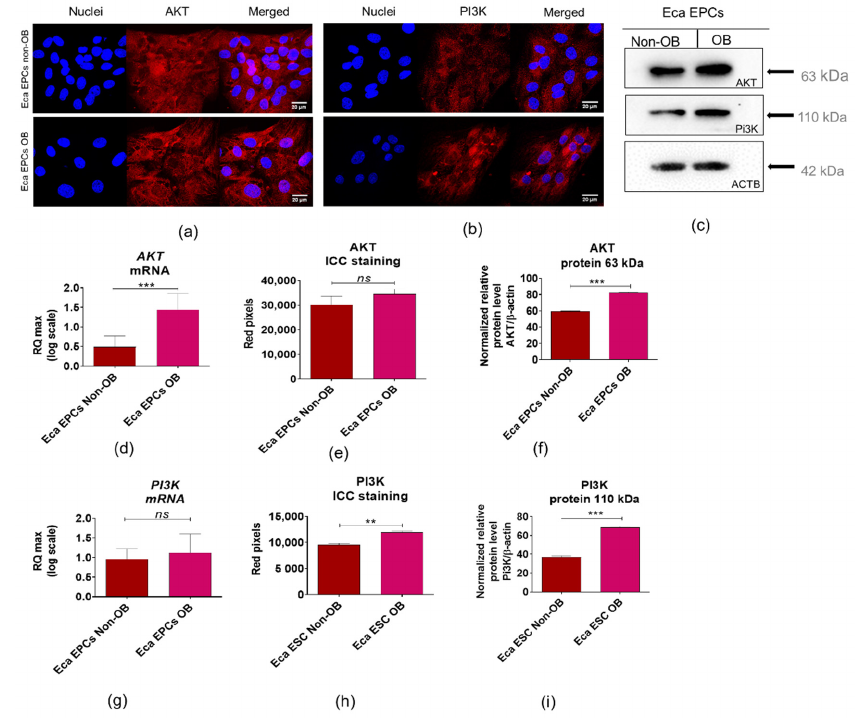
Figure 14. Expression of Pi3K/AKT determined and compared between EPCs non-OB and OB. The intracellular accumulation of AKT and PI3K was visualized using immunocytochemistry (ICC, a , b ) and determined with Western blot ( c ). RT-qPCR ( d – i ) was used to establish mRNA levels for genes of interest. Densitometry measurements of membranes were performed to compare expression of proteins between EPCs non-OB and OB. The protein levels were normalized to β -actin /ACTB ( e – i ). Significant differences were calculated for normalized values and shown as means ± SD. ** p -value < 0.01 and *** p -value < 0.001, while ns indicates non-significant difference. 4. Discussion The endometrium has gained attention as a source of progenitor cells with high pro- liferative potential. The endometrial progenitor cells (EPCs) are described as a multipotent population, i.e., able to differentiate into adipogenic, osteogenic, chondrogenic, and even myogenic cell lineages or neurons [32]. The pro-regenerative features of EPCs, with their self-renewal properties, make them a treatment option for endometrial healing. Their po- tential therapeutic application has been strictly associated with treating endometrial dis- eases in women, such as Asherman’s syndrome, characterized by endometrial scarring, fibrosis, and dense adhesions with occlusion of the uterine cavity and endometriosis [32,33]. However, because of the high cellular plasticity and multipotent properties of EPCs, their therapeutic effectiveness in regenerative medicine could be much broader. For instance, endometrial stem cells were proposed as an alternative therapeutic tool for Par- kinson’s disease [34]. Furthermore, in veterinary regenerative medicine, EPCs-based ther- apies could be a possible treatment for subfertility caused by endometrial dysfunction, which is a severe problem in the horse breeding industry [35]. Endometrial diseases occur commonly in mares without a specific etiology. Obesity and insulin resistance can affect reproduction in mares, impacting the em- bryo and uterus, as well as the oocyte [2]. We have previously shown that the regenerative